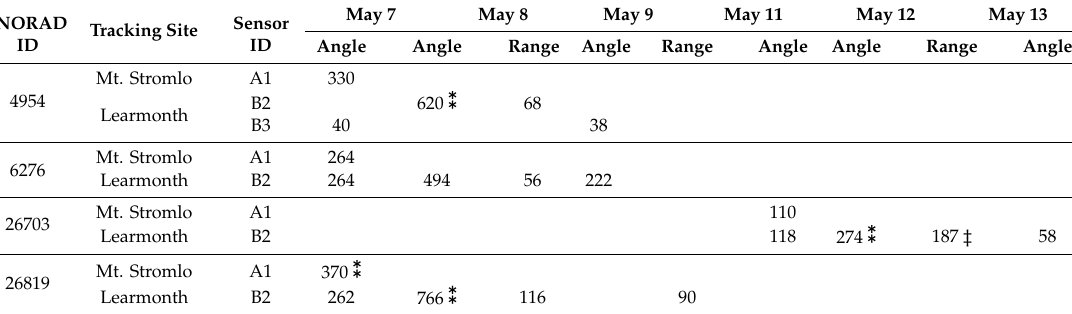
Table 5. The number of tracking data for the OD process (May 7–9, May 11–13, 2019).